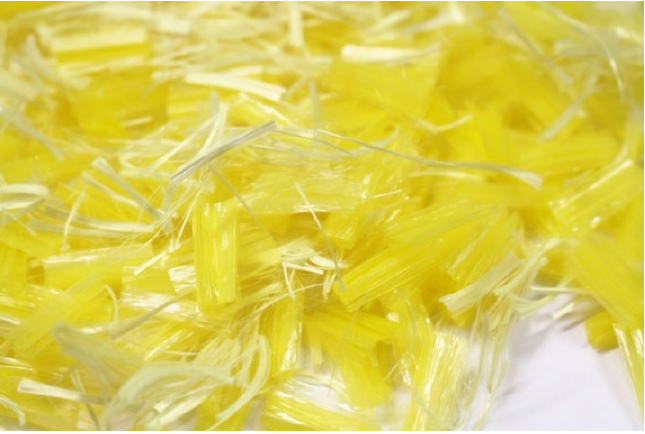
Figure 1. The aramid fibres Forta-fi [32].